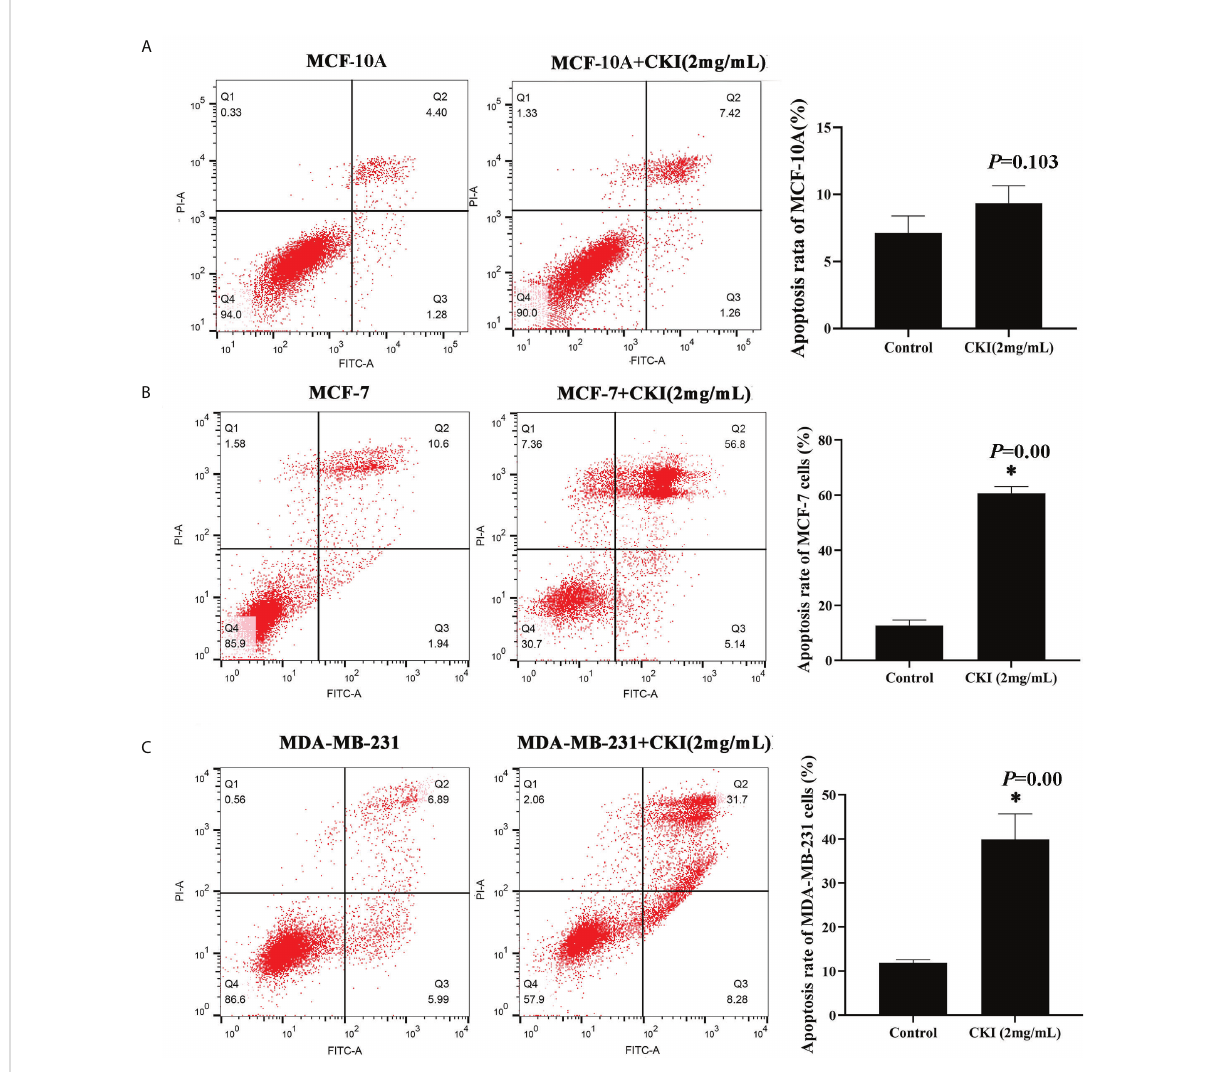
FIGURE 9 CKI induces apoptosis of MCF-7 cells and MDA-MB-231 cells. Notes: (A) Induction of apoptosis in MCF-10A cells with CKI treatment. (B) Induction of apoptosis in MCF-7 cells with CKI treatment. (C) Induction of apoptosis in MDA-MB-231 cells with CKI treatment. The level of apoptosis was determined by measuring the levels of Annexin V-FITC and PI staining. n=3. Data are presented as means ± SD. * P < 0.05, compared with MCF-10A(MCF-7 or MDA-MB-231)